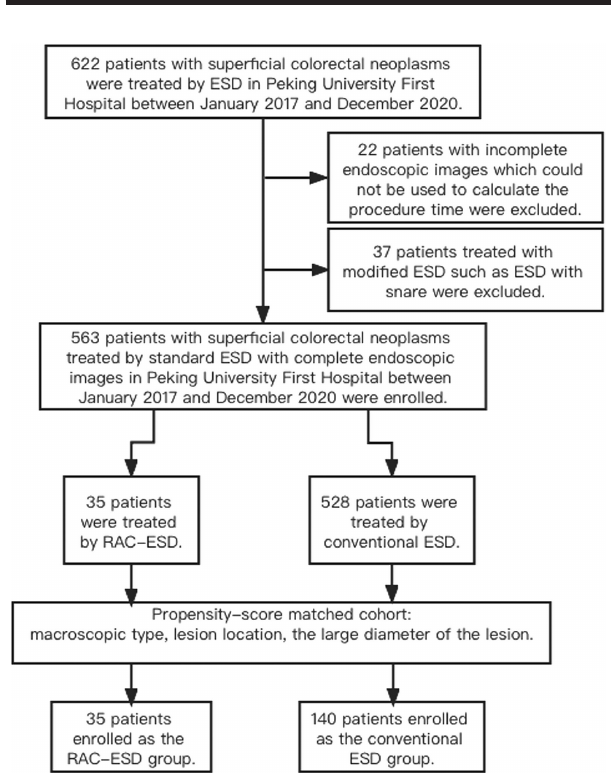
Figure 2. Study flow diagram. ESD, endoscopic submucosal dissection; RAC-ESD, inner traction-facilitated ESD using rubber band and